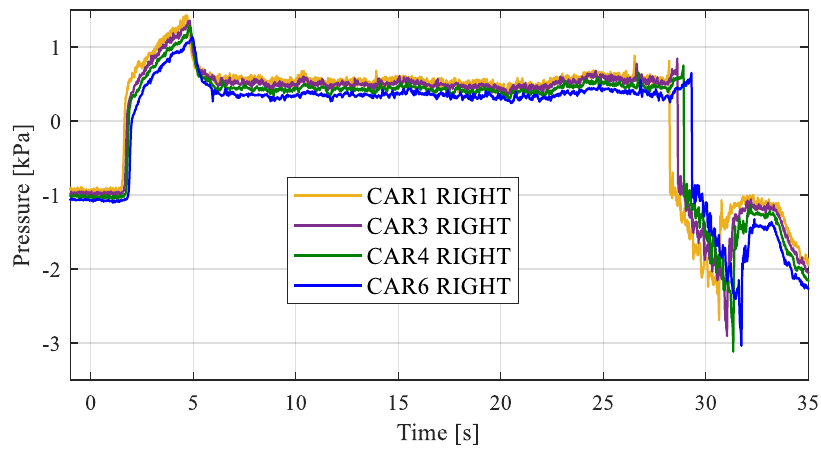
Figure 13. Comparison between the pressure acquired in di ff erent positions along the unsealed train.